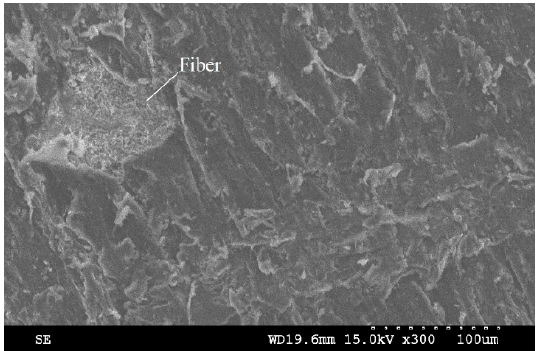
Figure 8. Surface roughness profile for drilled holes with different cutting conditions: ( a ) f = 0.2 mm/rev, d = 6 mm, s = 600 rpm; and ( b ) f = 0.3 mm/rev, d = 10 mm, s = 2400 rpm.